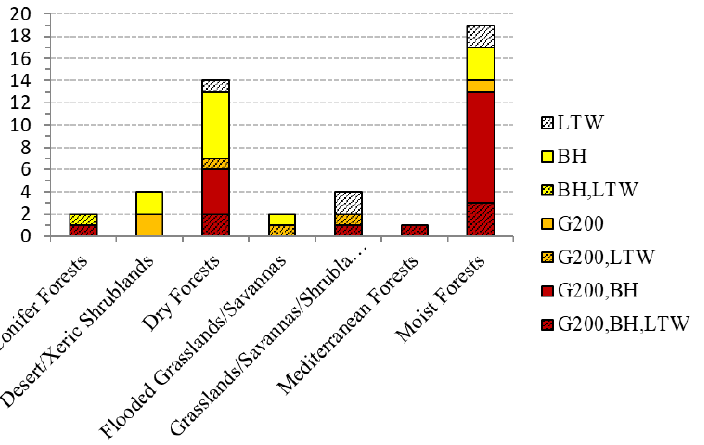
Figure 9. Number of ecoregions within biomes that had WCRI in the year 2010 greater ≥ 3 and